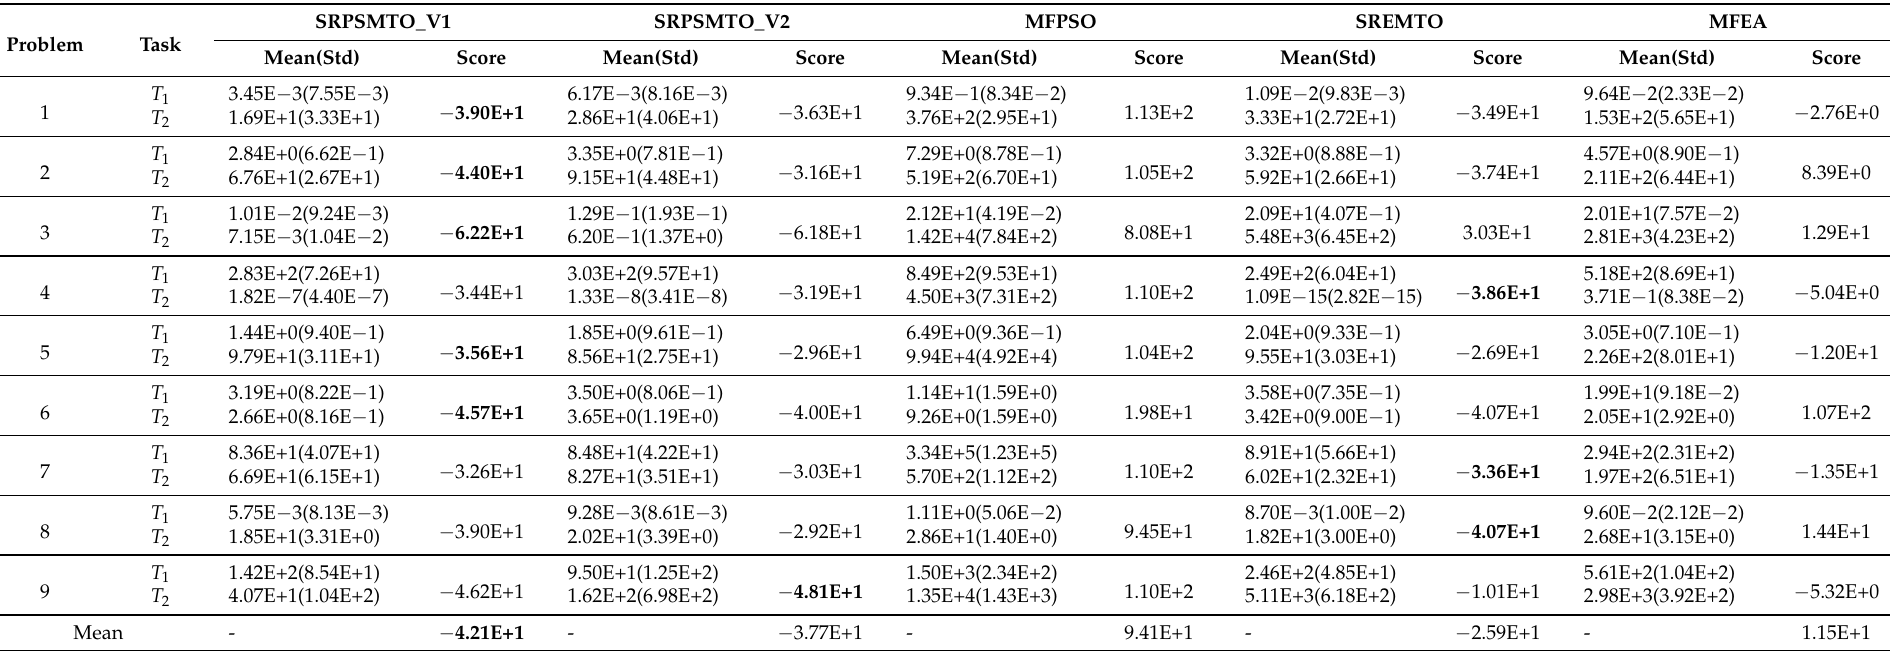
Table 5. Comparison of SRPSMTO, MFPSO, SREMTO and MFEA in terms of the means, bracketed standard deviations and scores of the best achieved FEVs over 30 runs on nine MTO problems in test suite 1. The best results are shown in